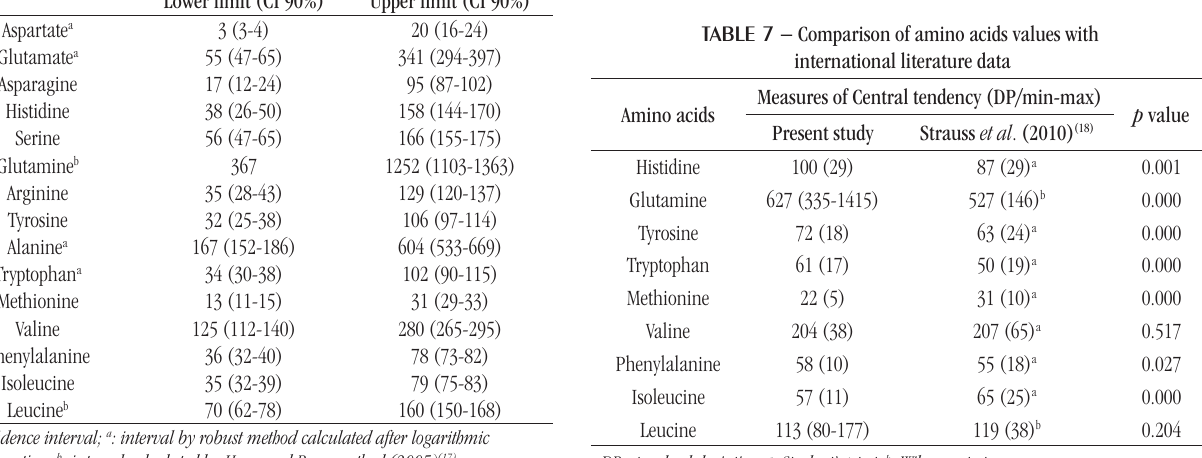
taBLE 6 − Reference ranges for plasma amino acids Amino acids (nmol/ml)